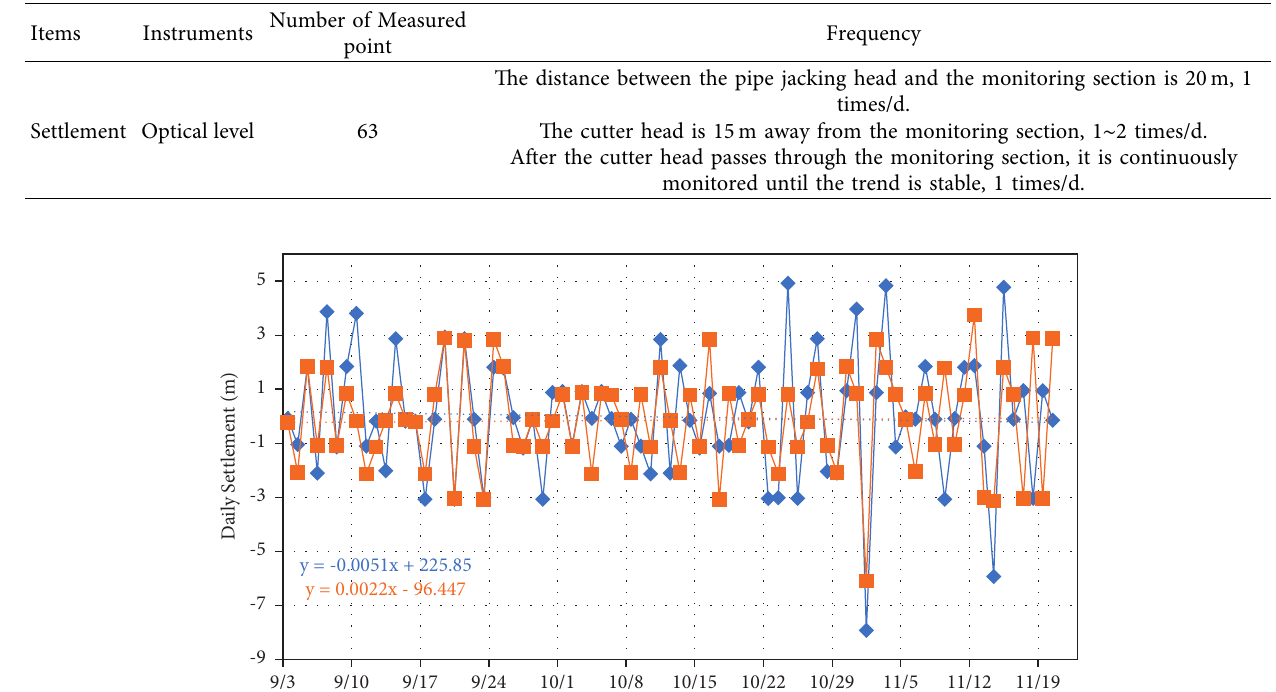
Table 3: Surface settlement monitoring.